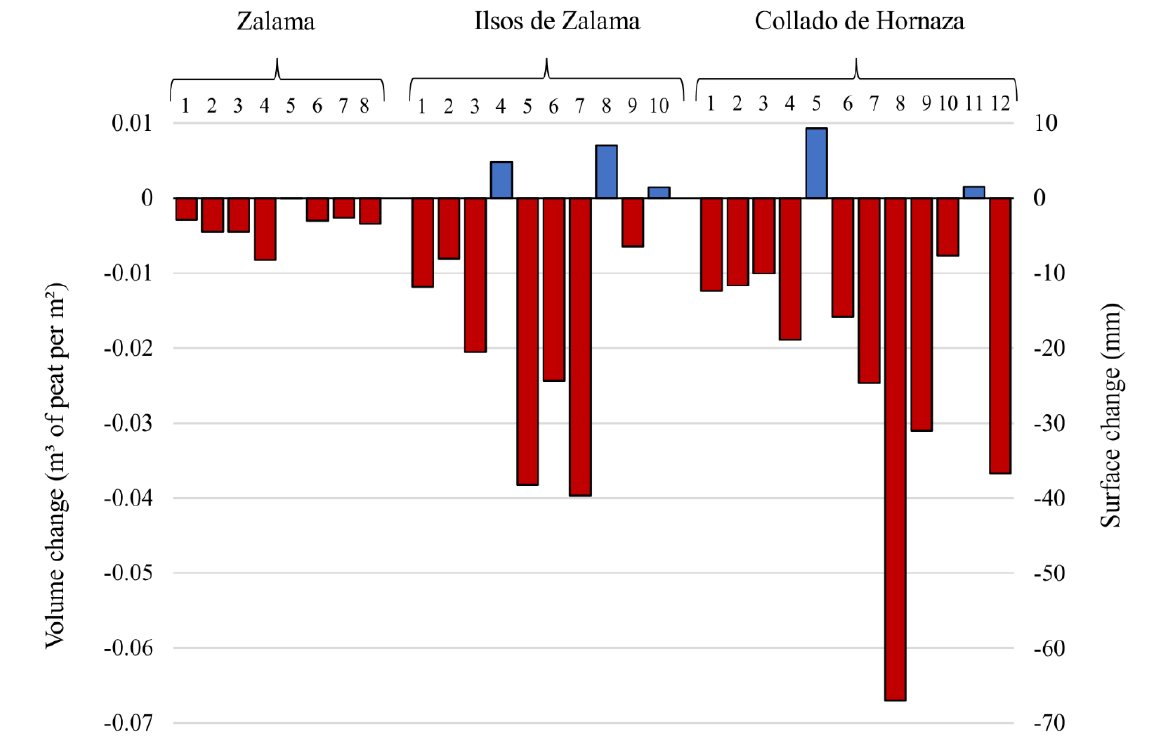
Figure 5. Mean peat volume change and mean surface change in each AOI.